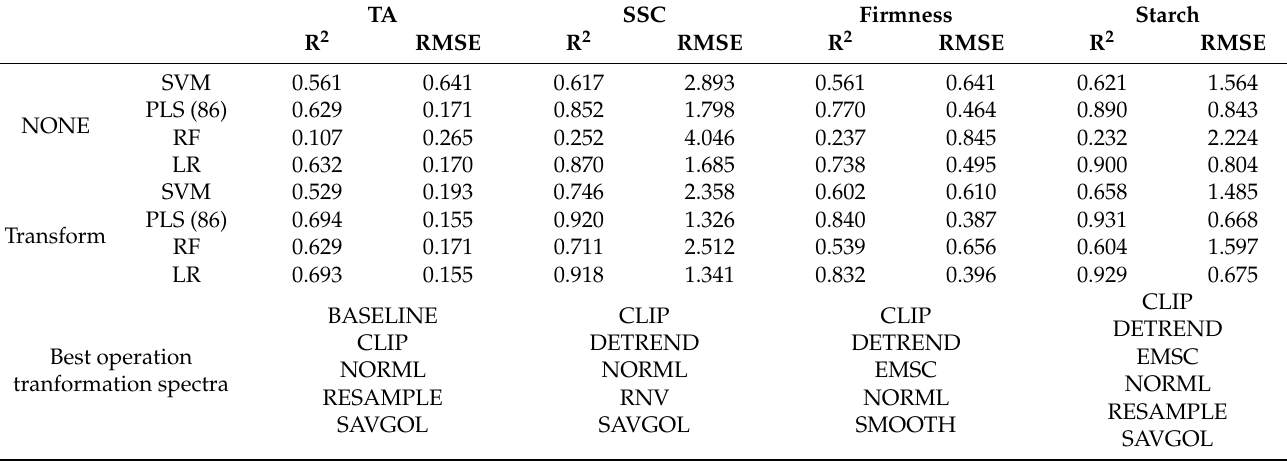
Table 6. Results of indirect comparison of